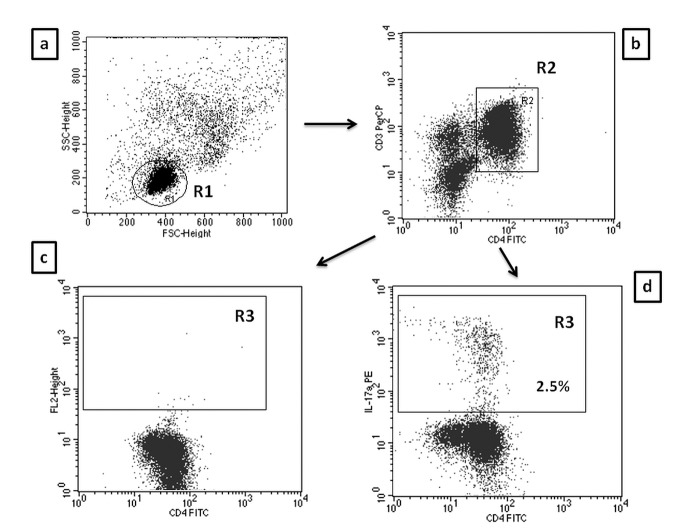
Evaluation of CD4/CD3+/IL-17A+ (Th17) cells frequency in ALD patients by flow cytometry.A. The lymphocyte subpopulation was gated (R1) based on linear forward vs. side scatter (FSC/SSC) characteristics. B. The R1 cells were further evaluated for CD3 PE-Cy5 and CD4 FITC staining with subsequent CD4+/CD3+ cell identification (region R2). C. Dot plots of CD4FITC versus mouse IgG1 PE were established (controls). D. Dot plots of CD4FITC versus IL-17A PE were established by combined gating of R1 and R2 events. The R3 region represents the percentage of CD4+/CD3+/IL-17A+ (Th17) cells among all CD4+CD3+ lymphocytes.